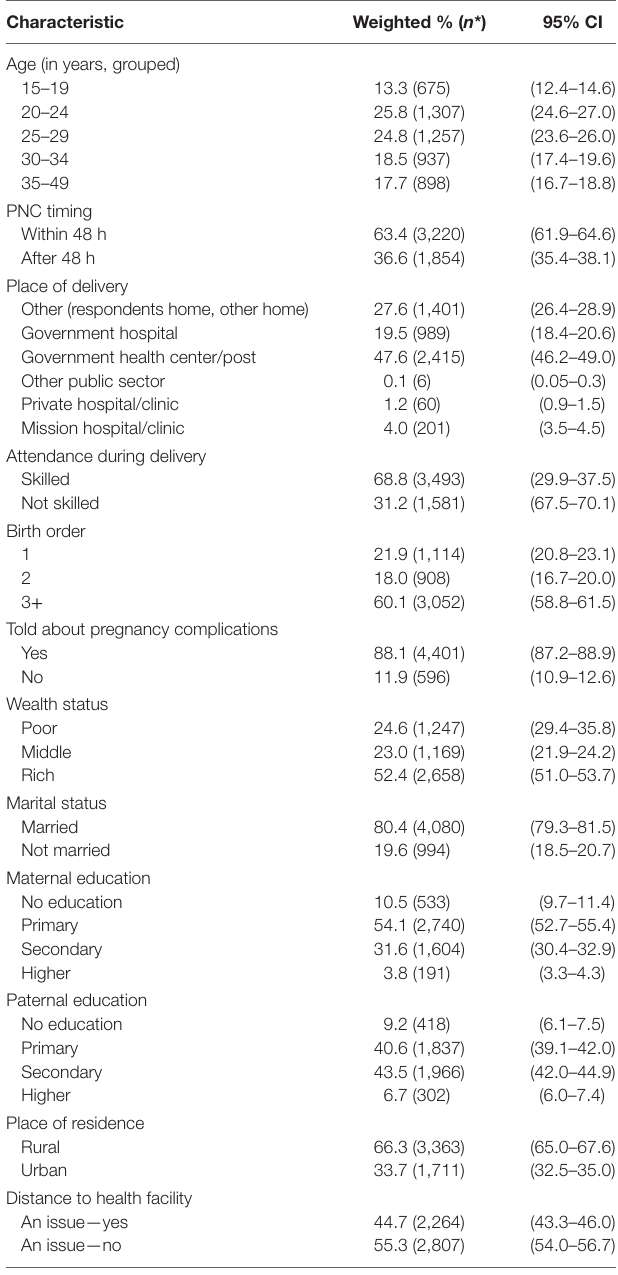
Table 1 | Basic characteristics of childbearing women utilizing postnatal care (PNC) in